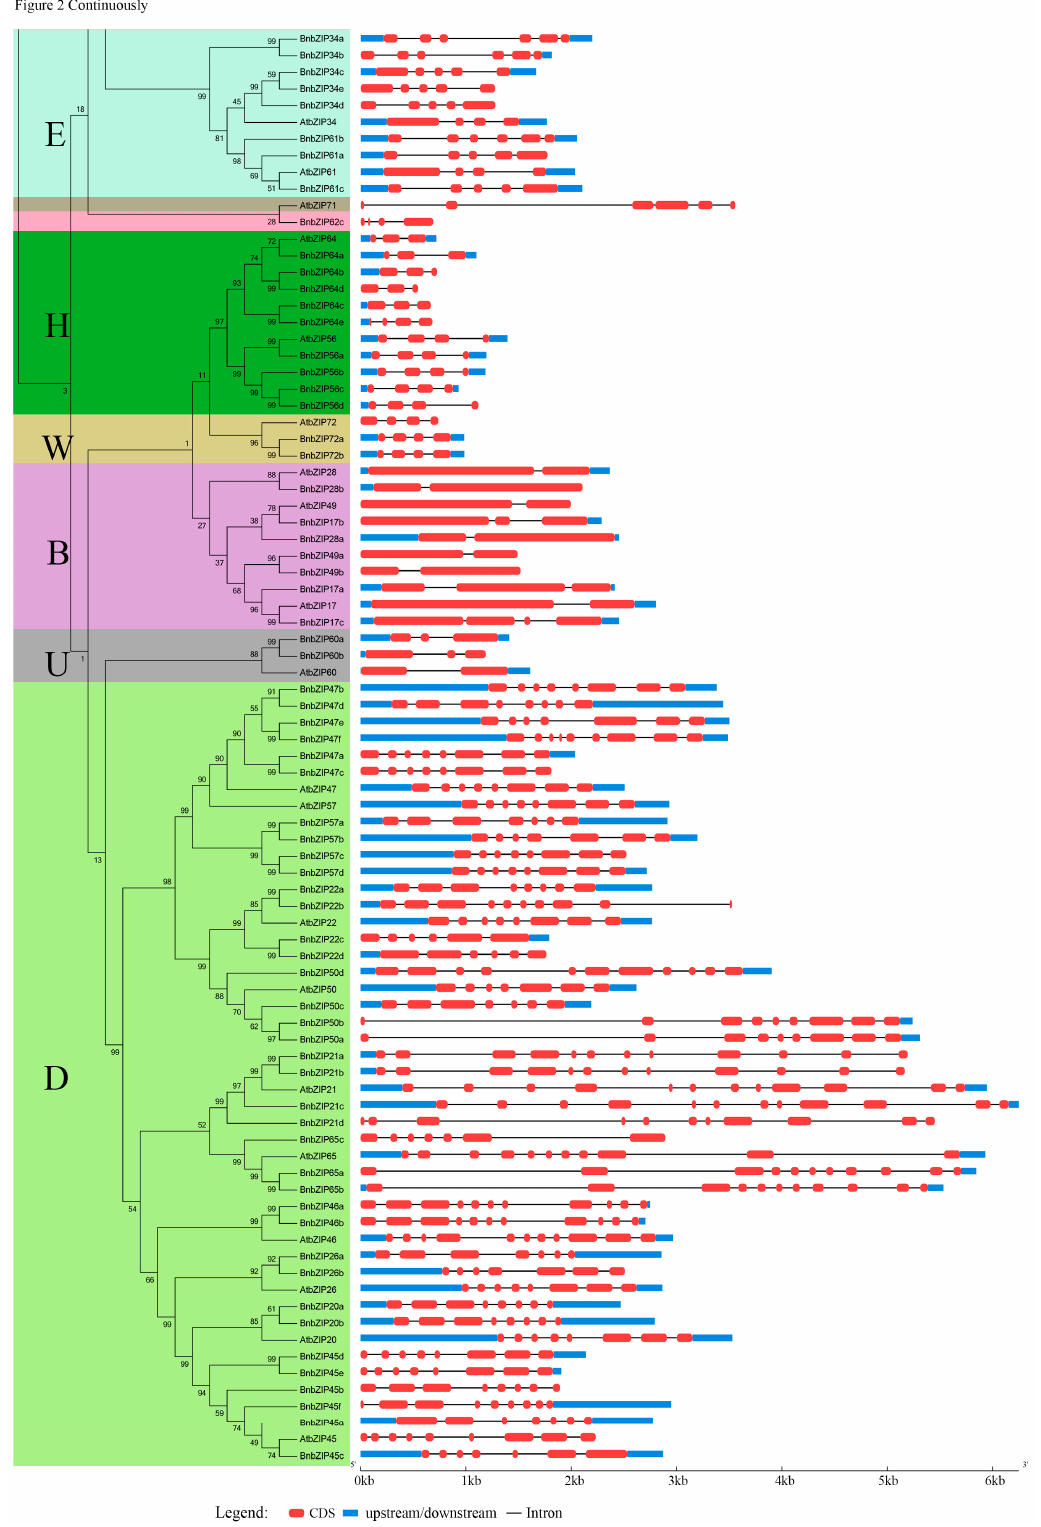
Figure 2. Sequences analysis of exon-intron structures of the BnbZIP genes. The red boxes indicate exons. Solid lines indicate introns (connecting two exons). Untranslated regions (UTRs) are indicated by blue boxes. The length of BnbZIP genes were indicated by horizontal axis (kb).